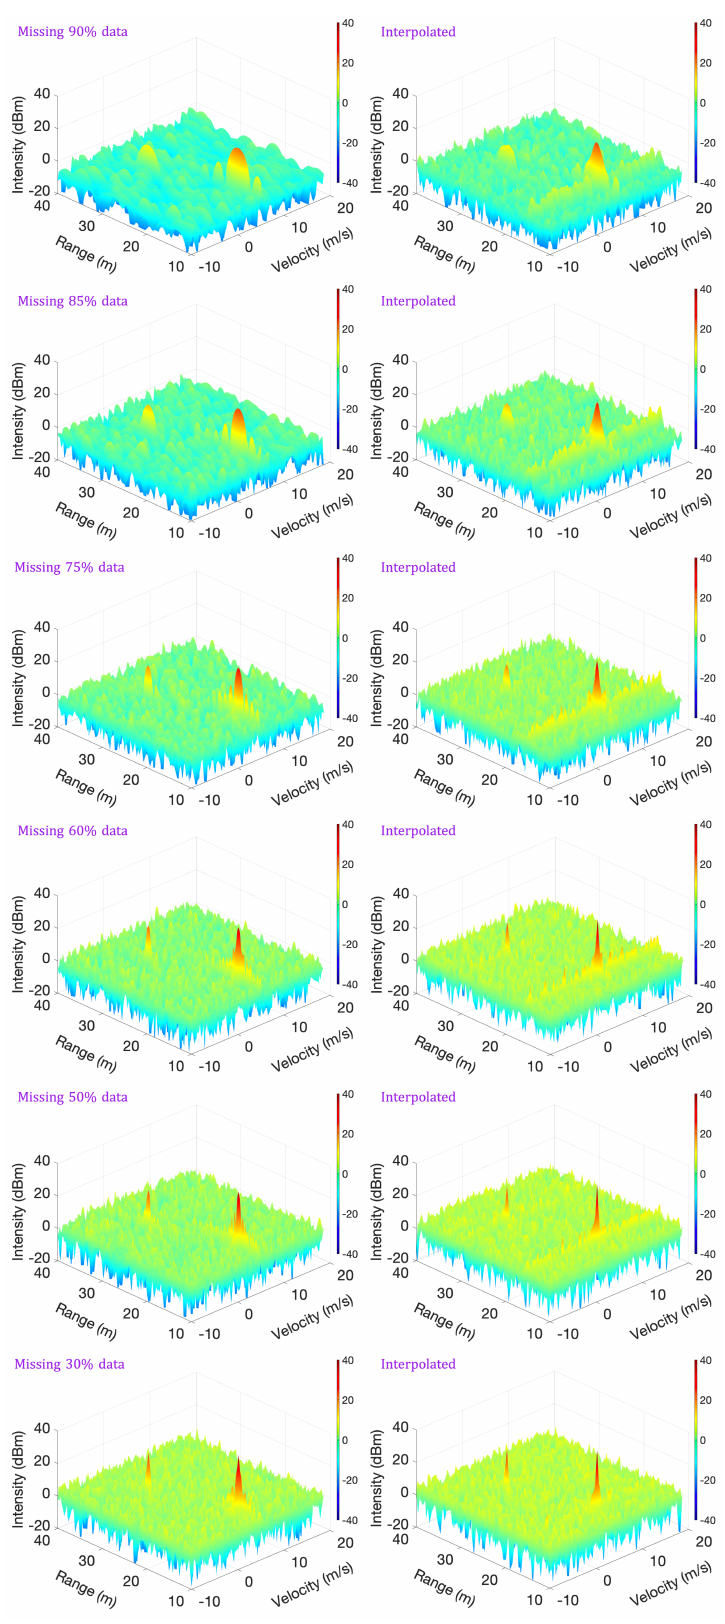
Figure 12. The performance of the proposed technique with respect to different percentages of interfering